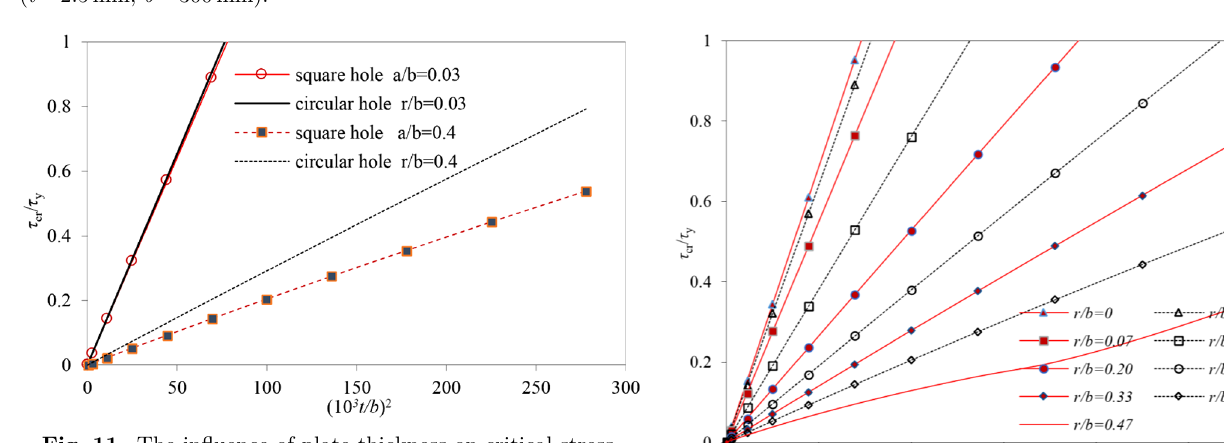
Fig. 11. The in fl uence of plate thickness on critical stress.